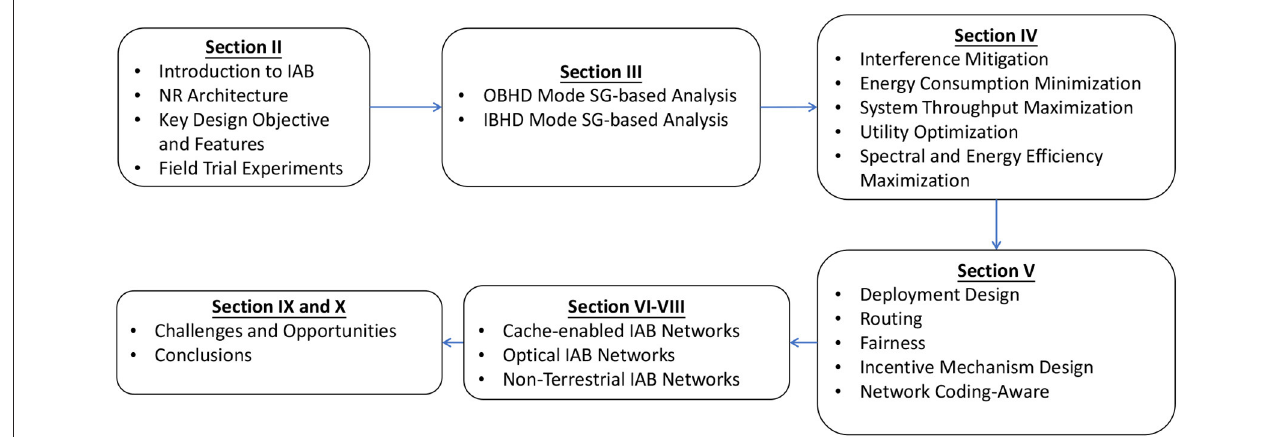
FIGURE 1 | Organization of the survey.